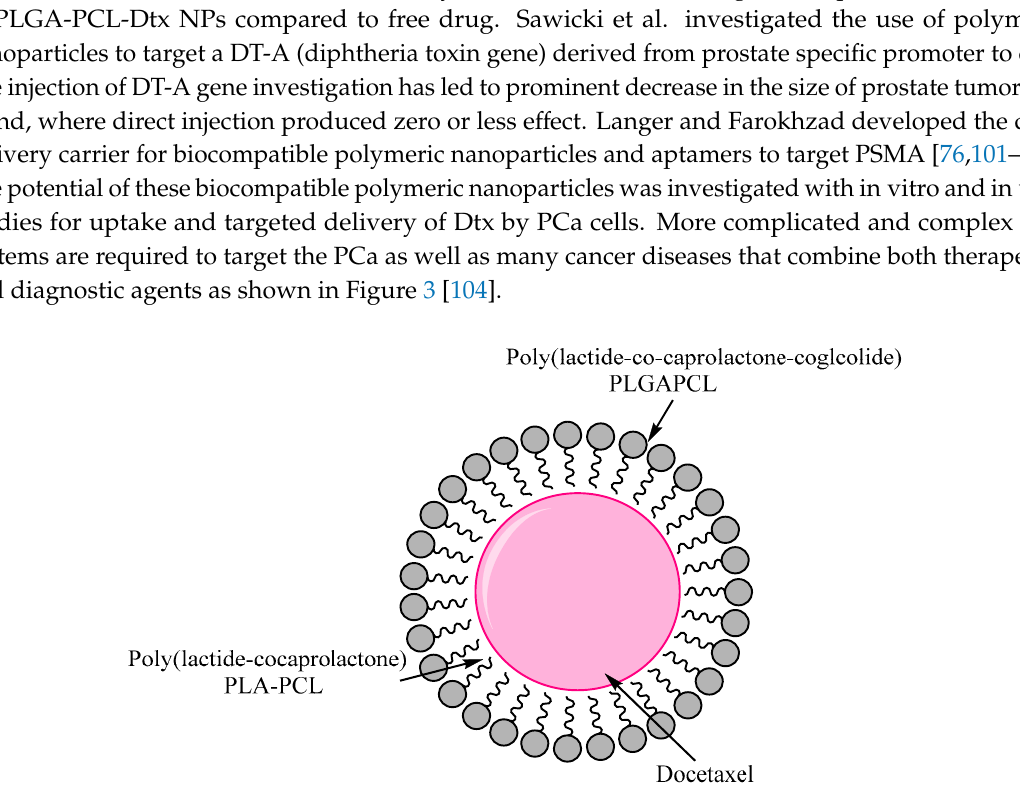
Figure 3. Polymeric PLGA-PCL and PLA-PCL biodegradable nanoparticles loaded with Docetaxel for targeting PCa. Reproduced from [79] with permission from DeGruyter, 2017.